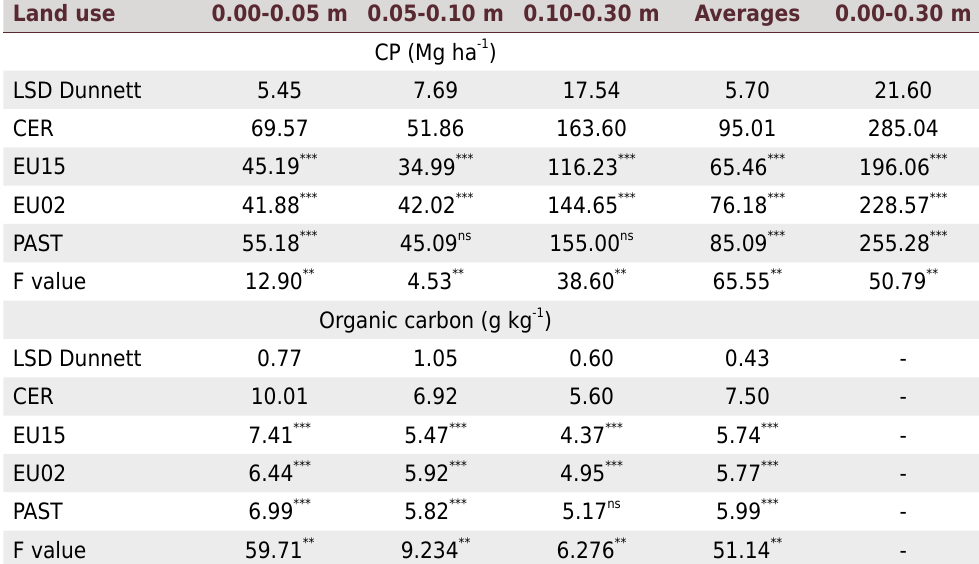
Table 5. Partitioning of the interaction between CER and each land use (preserved Cerrado - CER, 15-year-old Eucalyptus - EU15, 2 year-old Eucalyptus - EU02, and Pasture - PAST) in each soil layer for organic carbon pool (CP), and organic carbon (OC) Land use